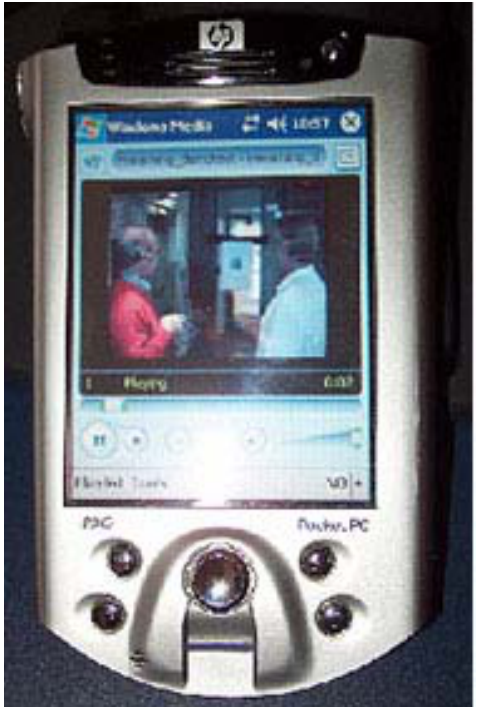
Figure 5 . Video on the